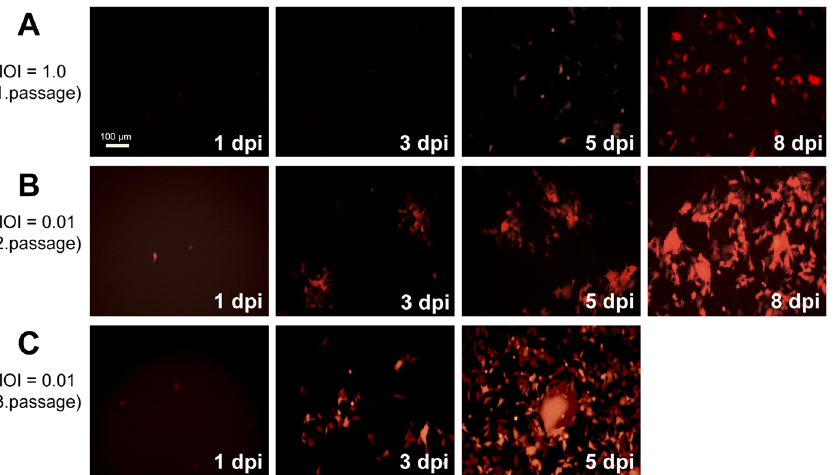
Figure 1. Infection of human epithelial cells H358 with CDV-A75/17 red . H358 cells were infected with recombinant wild-type CDV-A75/17 red at a MOI of 1.0 ( A ), incubated for the indicated times and pictures of the red autofluorescence taken under UV light. At 8 days post-infection (dpi) virus was prepared and titrated using Vero-cSLAM cells, and H358 cells infected with this virus at a MOI of 0.01 ( B ). After 8 dpi virus was again prepared and titrated using Vero-cSLAM cells, and H358 cells were infected with this virus at a MOI of 0.01 for indicated times ( C ). Photomicrographs